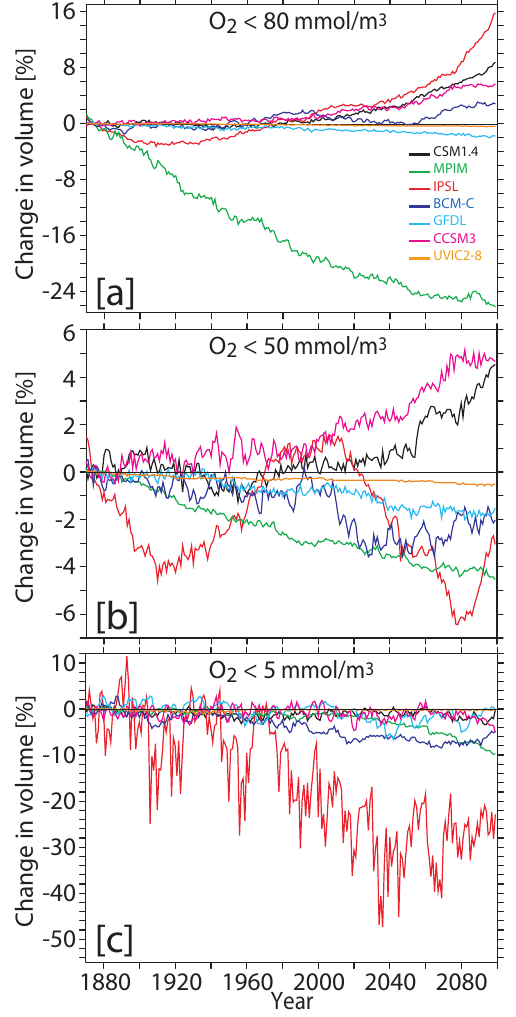
Fig. 7. Projected evolution of the global ocean volume occupied by (a) low-oxygenated waters (O 2 < 80mmolm − 3 ), (b) hypoxic waters (O 2 < 50mmolm − 3 ) and (c) suboxic waters (O 2 < 5mmolm − 3 ) for the SRES A2 scenario and the range of models. Changes are given in percent of the 1870s volume, relative to each low-O 2 class and each model.